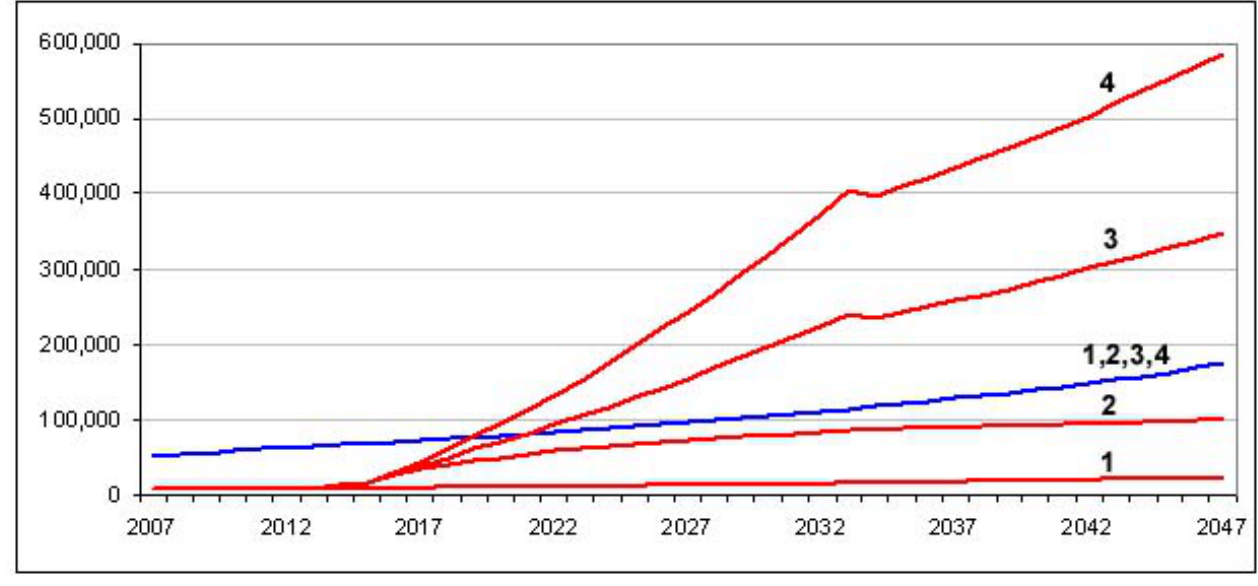
Fig. 4. A 40-year simulation of total local population (blue lines) and migrant population (red lines) in Malinau district, under the four different scenarios (1= no plantation; 2 = IPK clearing without plantation development; 3 = plantation development assuming low employment; and 4 = plantation development assuming high